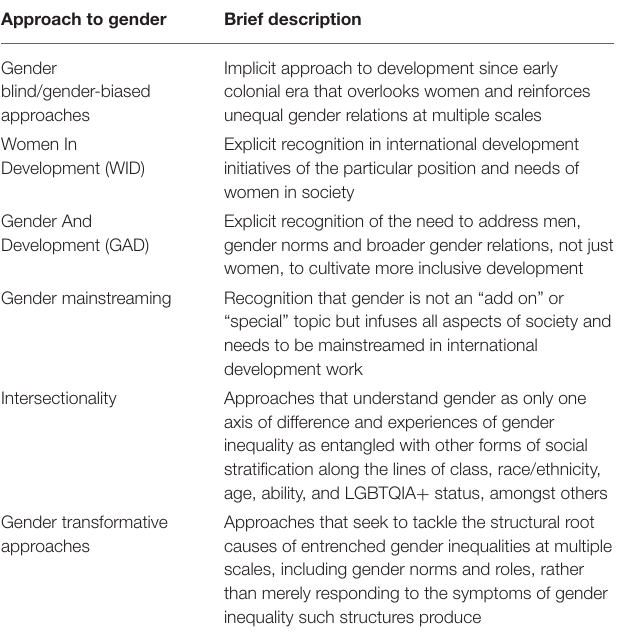
TABLE 1 | Overview of main approaches to gender in agriculture for development. Approach to